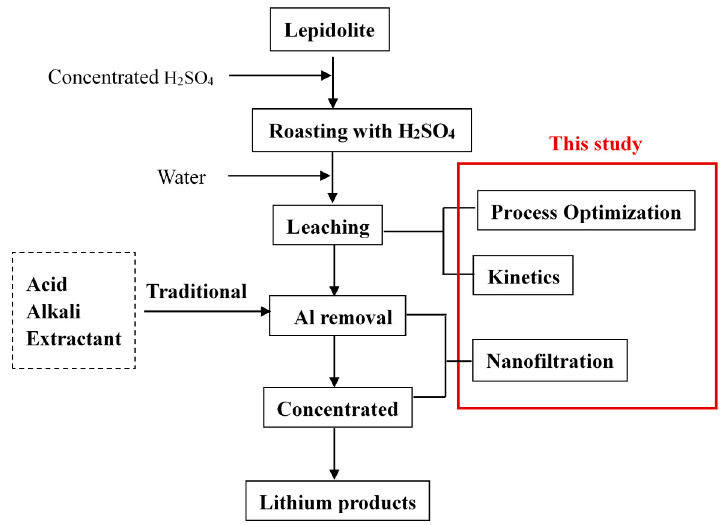
Figure 1. Roadmap difference between this study and traditional research.